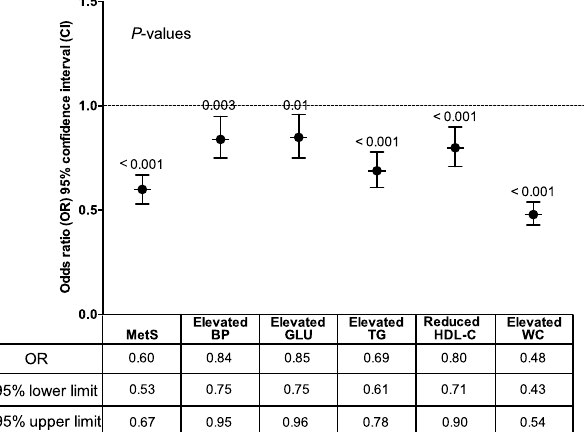
Figure 4. Association between Aflatoxin B1 (AFB1) and MetS in rural areas located in Southwest China. Higher AFB1 exposure decreased the risk of MetS (OR = 0.60, 95% CI: 0.53–0.67) and all its constituents after adjustment for age, sex, HBV infection, MC-LR exposure, alcohol drinking, cigarette smoking, labor strength, education level, family income, and fat, salt, vegetable and fruit